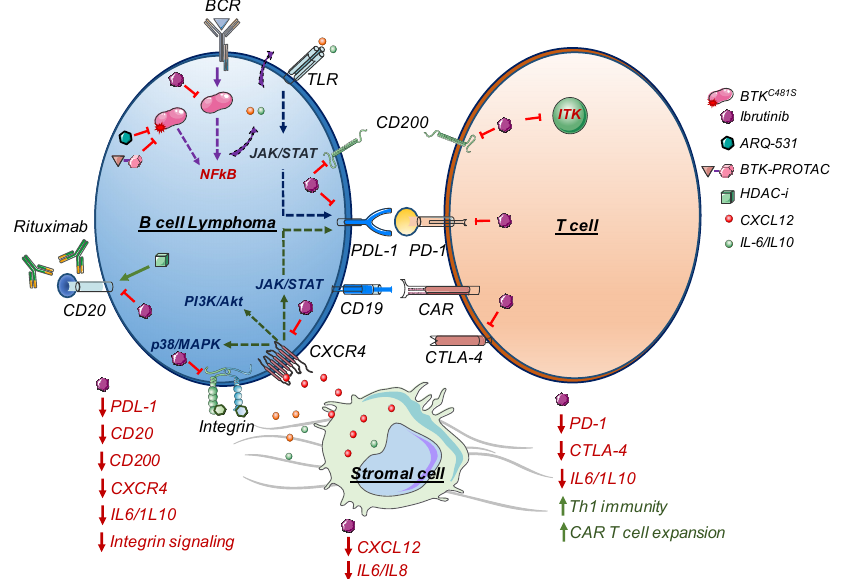
Figure 1. Ibrutinib’s mechanism of action and strategies to overcome ibrutinib resistance. Ibrutinib treatment has been shown to negatively influence TME and have immunomodulatory functions.